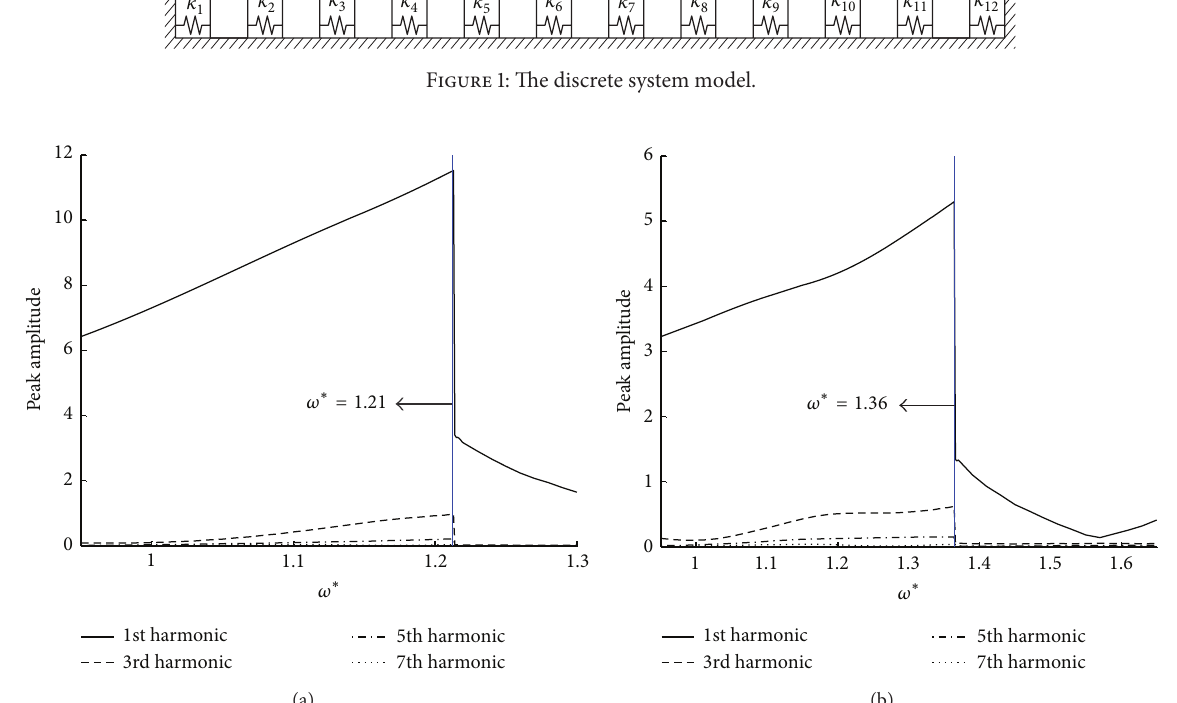
Figure 2: The response peak amplitudes of each harmonic at 8th DOF: (a) weakly nonlinear system; (b) essentially nonlinear